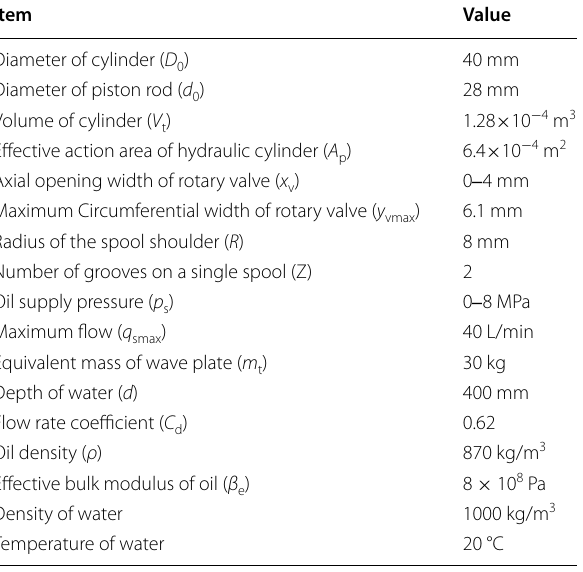
Table 2 Main parameters of new wave maker system